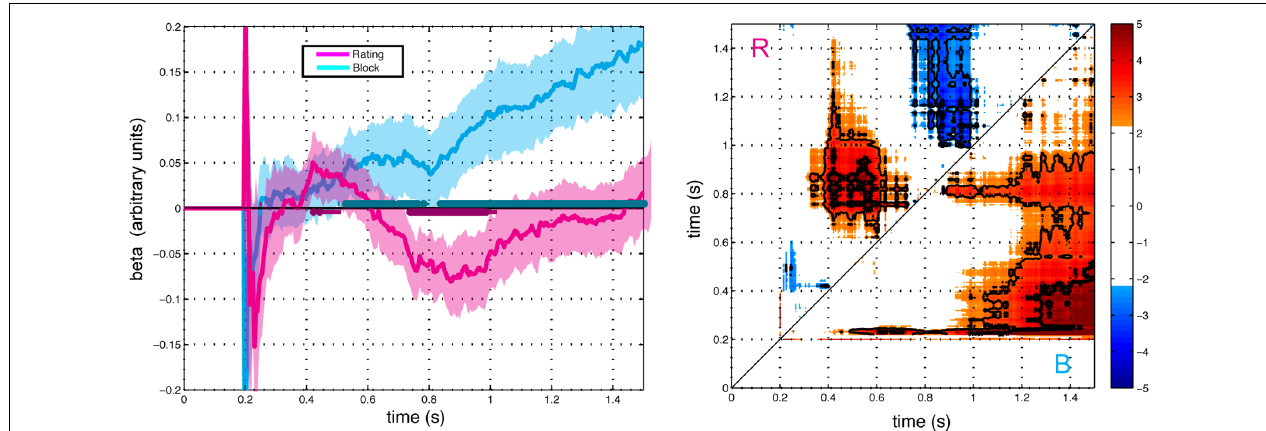
t-scores for the paired contrast between time points thresholded at FDR corrected significance level Q < 0.1. Regions for Q < 0.05 and Q < 0.01 are indicted with thin and thick contour lines, respectively. Points represent the t-score for the paired difference between rating parameter at the time indicated at the abscissa minus the time indicated at the ordinate.